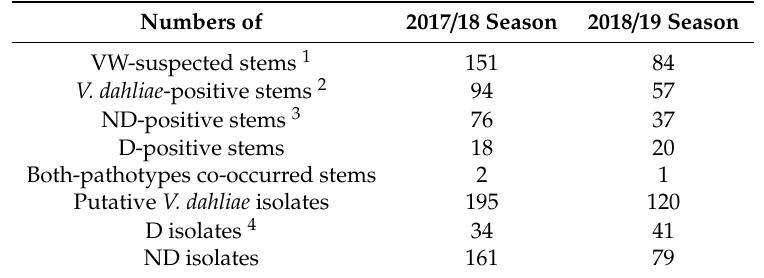
Table 1. Number of V. dahliae isolates including pathotype designations recovered from Verticillium wilt (VW) disease-suspected stems sampled during the two survey seasons between 2017 and